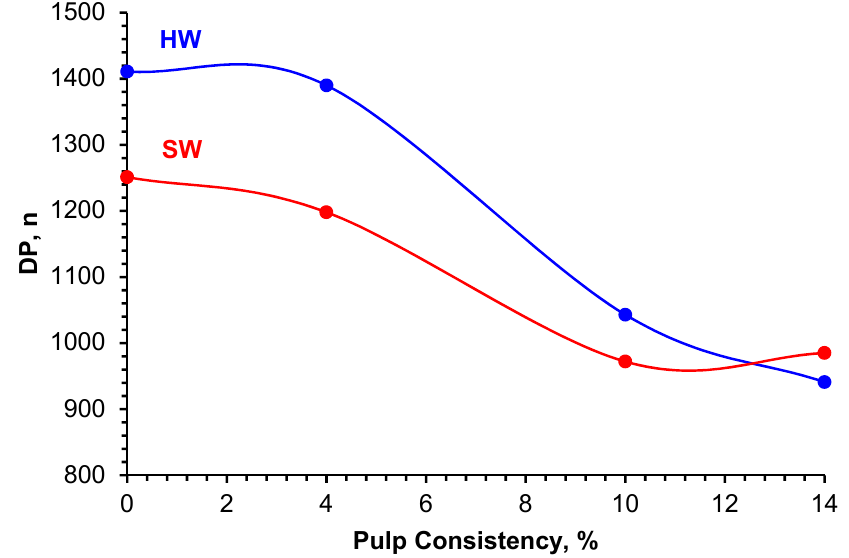
Table 3. Determination of the degree of polymerization (DP) for oxidized pulps.